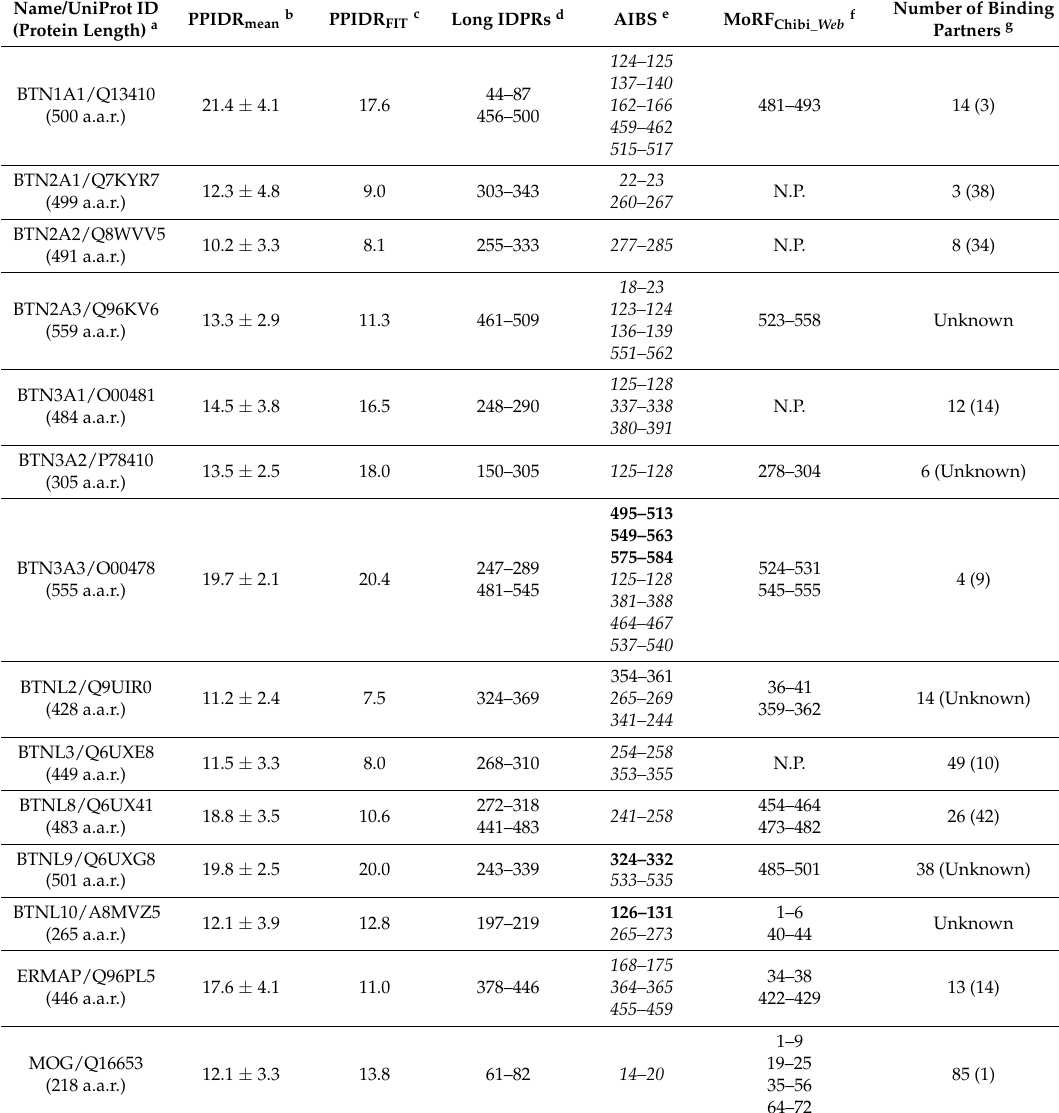
Table 1. Evaluation of intrinsic disorder propensity of the members of human butyrophilin